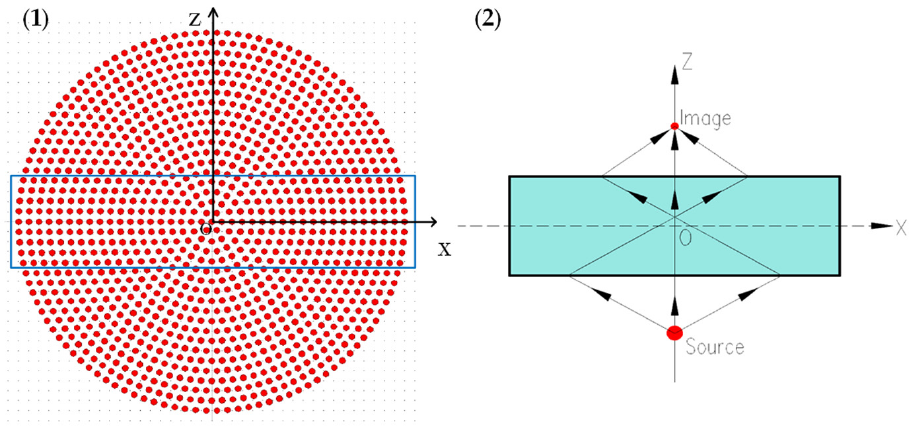
Figure 1. ( 1 ) Sunflower structure schematic diagram. ( 2 ) Analysis model of imaging characteristics of 2D QPC flat lens.